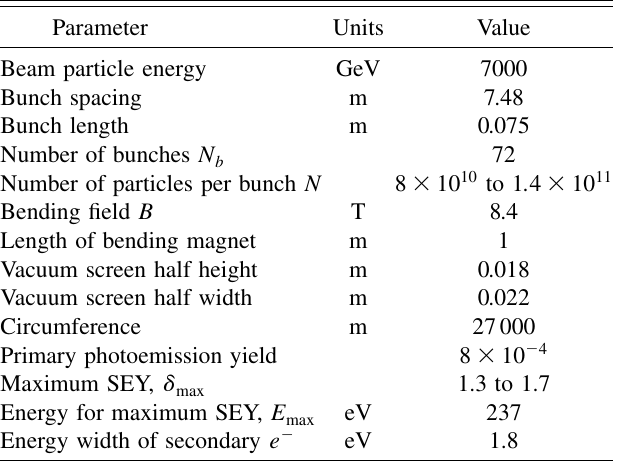
TABLE I. Input parameters for ECLOUD